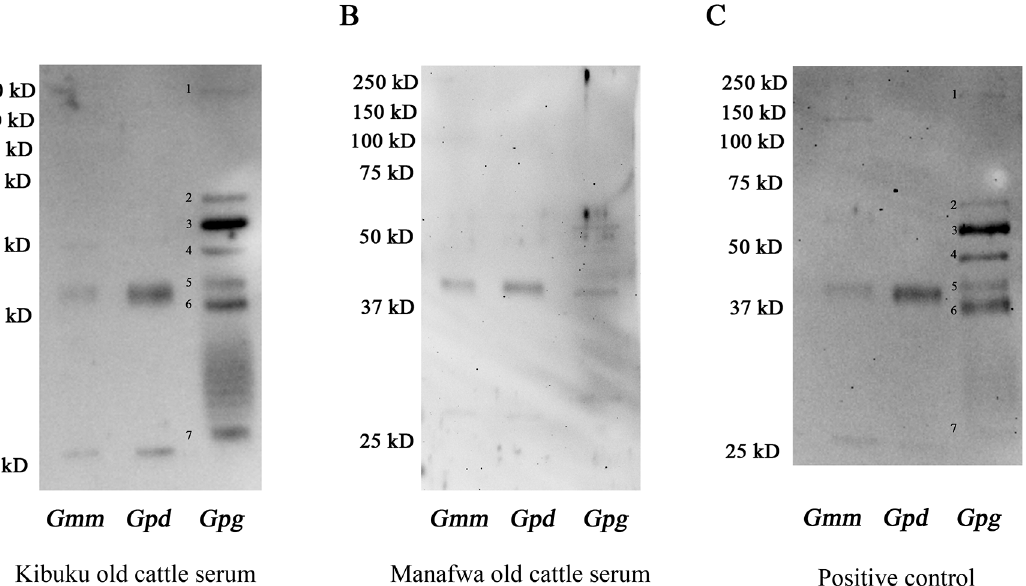
Fig 5. Immunoblot analysis of sialome proteins from Gmm , Gpd and Gpg using endemic cattle sera. Sialomes from Gmm , Gpd , and Gpg were analyzed with sera from (A) 8 – 12 year old cattle from Kibuku district, (B) 10 – 15 year old cattle from Manafwa district and (C) cattle used for Gff colony maintenance included as positive